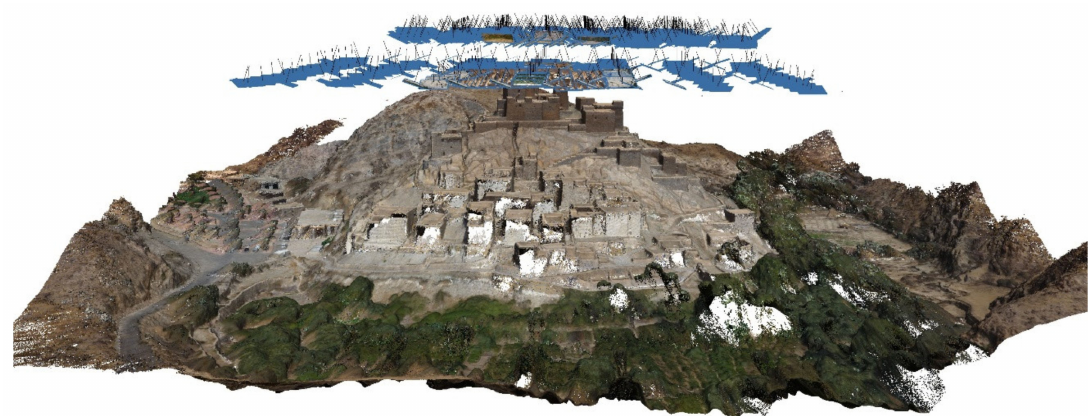
Figure 11. The point cloud obtained using nadir and oblique UAV